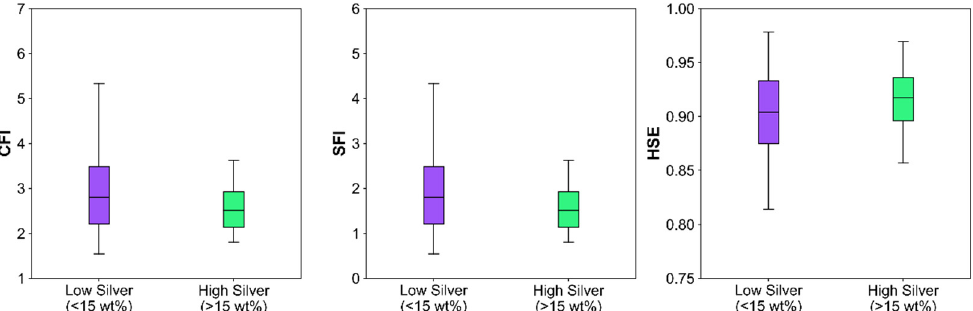
Figure 11. Morphological index variations for the two compositional sub-populations. Low silver population shows a broader range of values and higher maximum values than high silver particles, exhibiting possible differences in their transport. CFI: Cailleux’s flatness index, SFI: Shilo’s flatness index, HSE: Hofmann’s shape entropy.